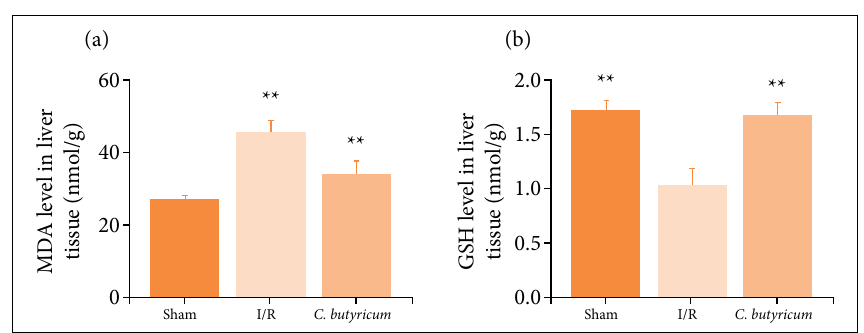
Figure 3 - The (a) MDA and (b) GSH levels in the liver tissue. ** p < 0.01 vs. the sham group; ## p < 0.01 vs. the I/R group.